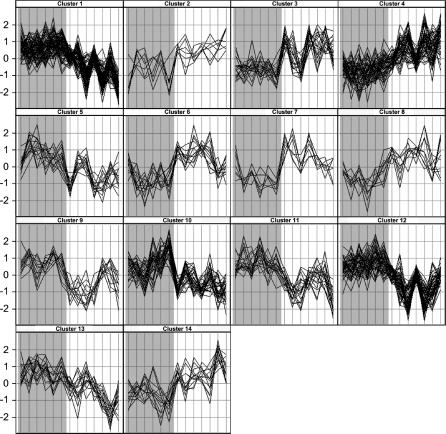
Profiles of Gene Expression in the Uterine Fundus from Women before or after the Onset of LaborEach panel shows profiles of the genes within one of the clusters determined jointly by K-means and hierarchical clustering. On the
x-axis, samples from individual patients are arranged and represented by vertical lines. Non-labor samples (gray background) are shown on the left and labor (white background) on the right. The
y-axis represents the level of gene expression as a number of standard deviations from the mean of all observations for each gene (
z-score).